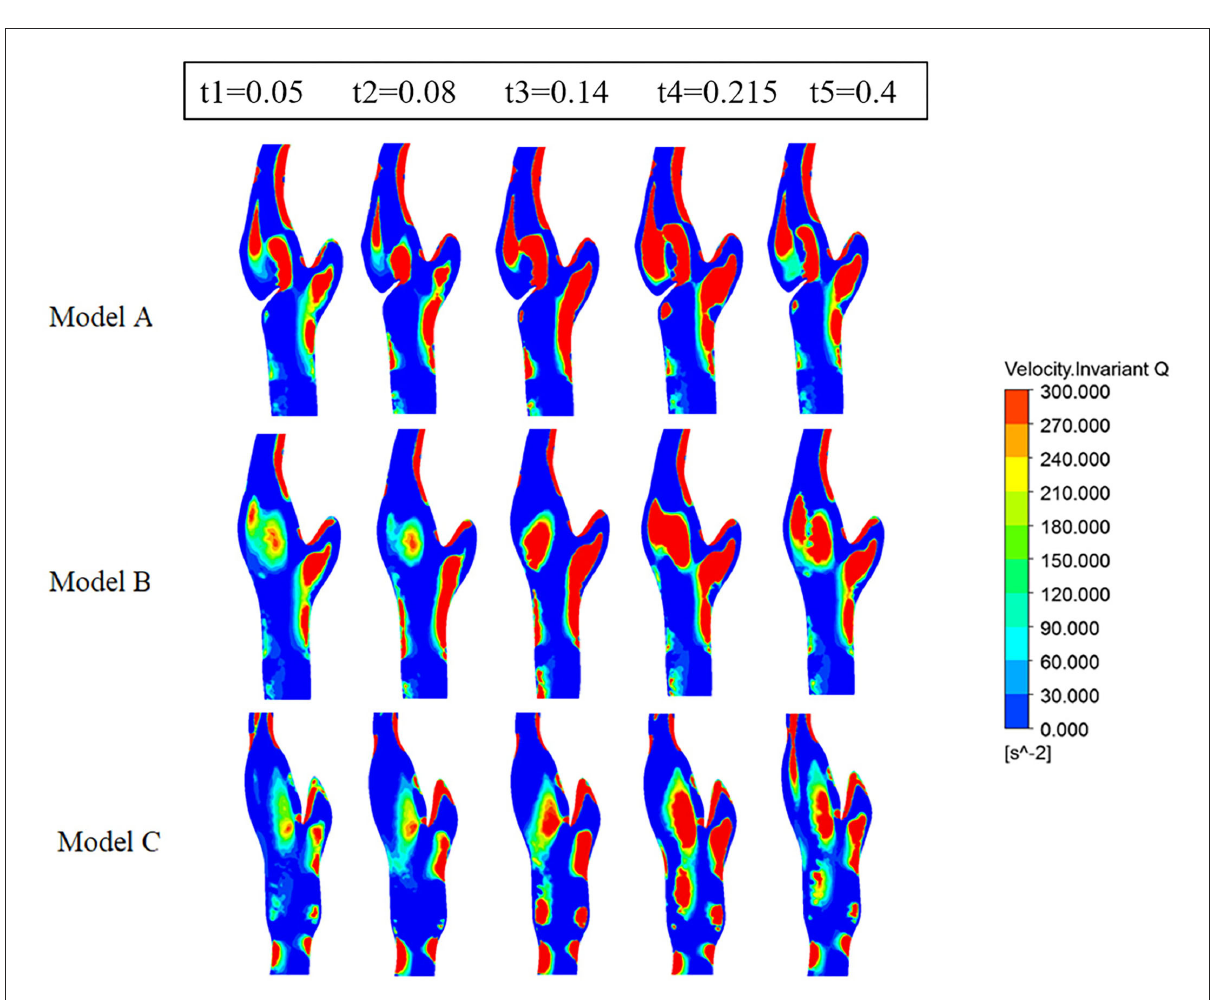
FIGURE6 Contours of Q-criterion on the cross sections at five